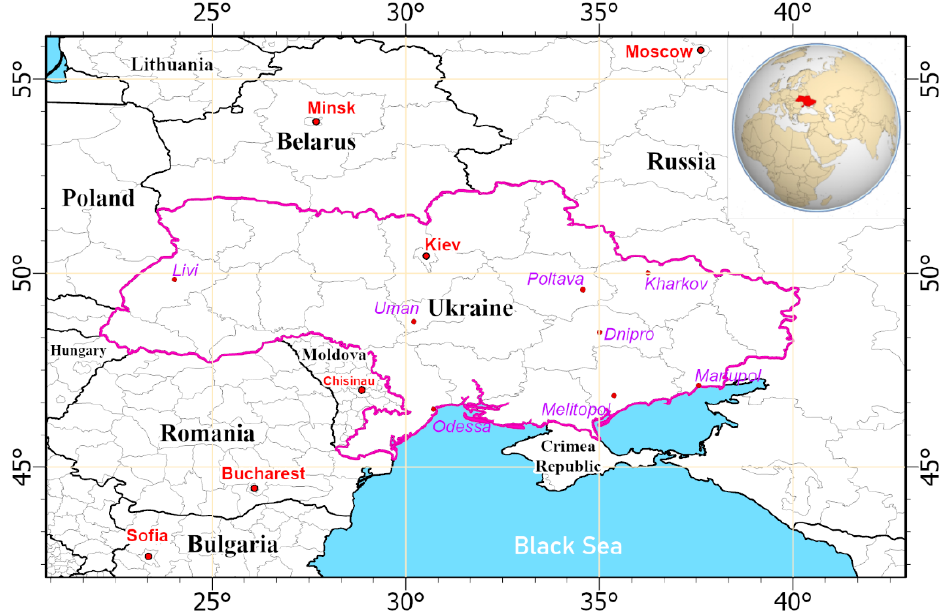
Figure 2. Location map of the study area (red highlighted spot in the upper right corner is the location of the Earth view).